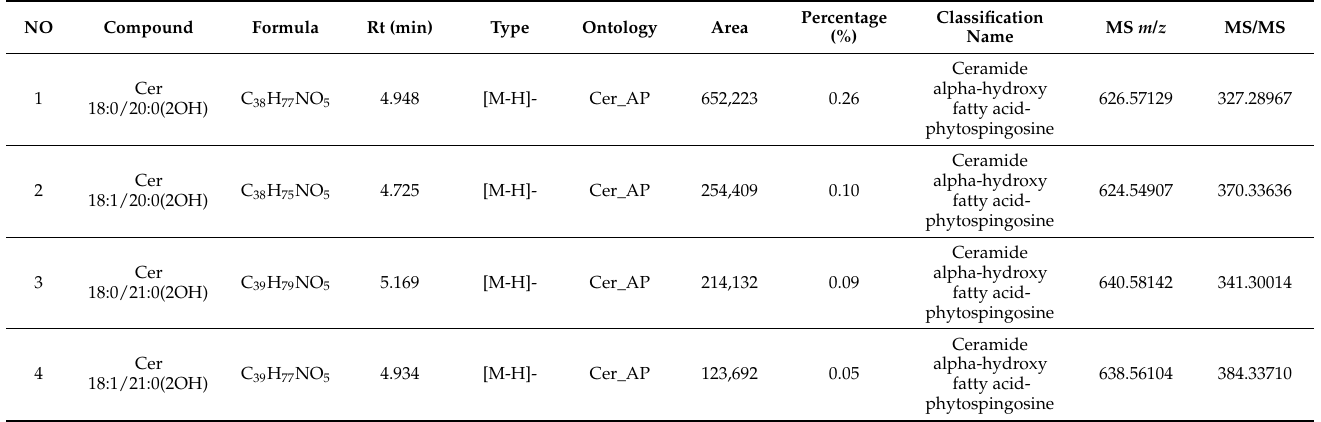
Table 4. UHPLC-Triple-TOF-MS/MS identification of